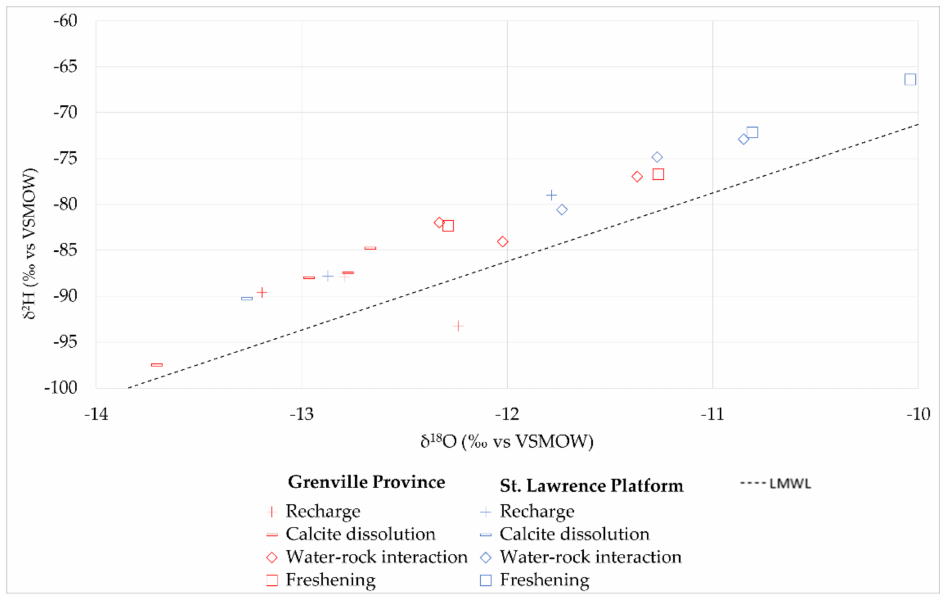
Figure 13. Binary diagram of δ 2 H vs. δ 18 O for 20 samples from the Grenville Province and St. Lawrence Platform. The dashed line represents the local meteoritic water line